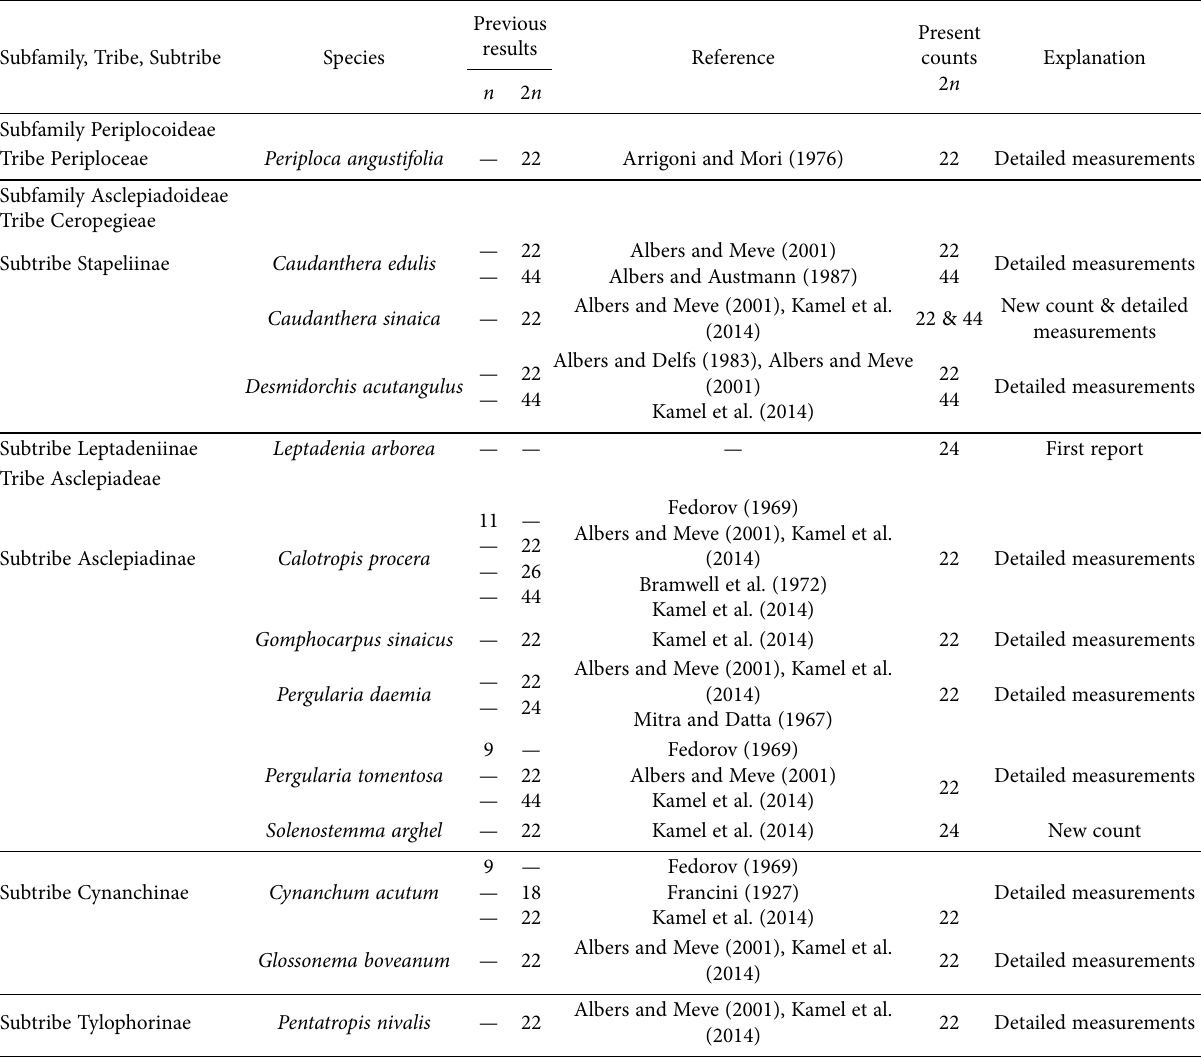
Table 2. The gametic and somatic chromosome counts of the investigated species in present and previous studies.